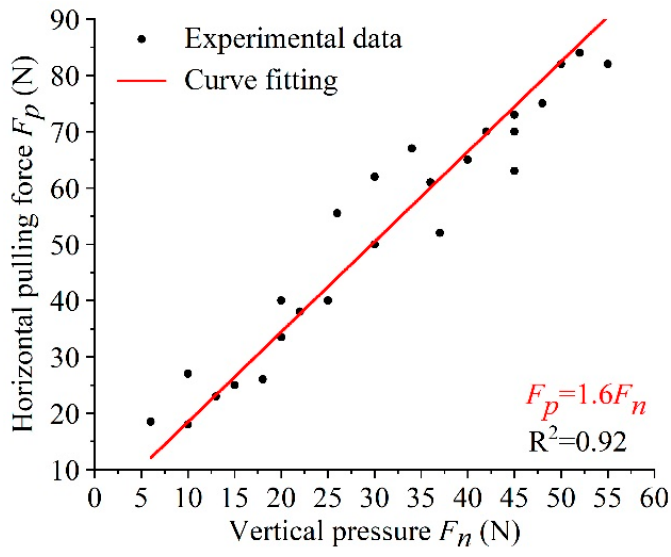
Figure 16. Test data and fitting curve.